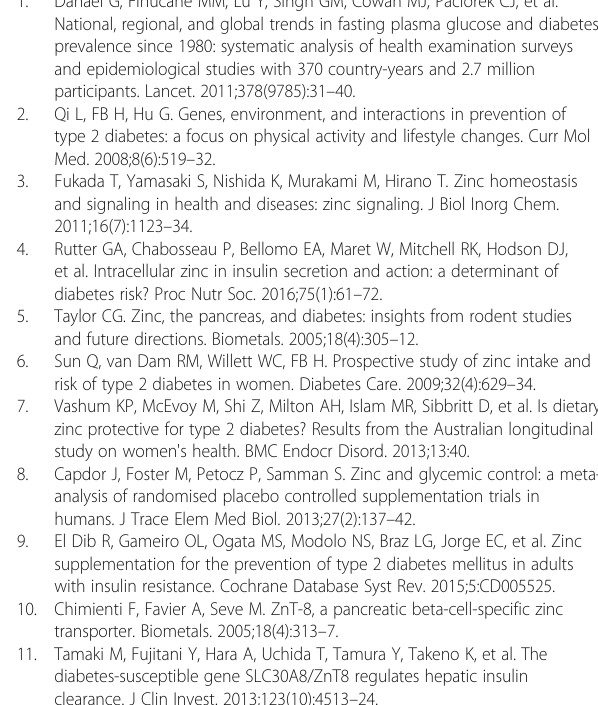
Additional file 1: Figure S1. Flow chart of analytical study population. Figure S2. Nelson-Aalen cumulative hazard estimates for type 2 diabetes by SLC30A8 rs13266634 genotype among 20,929 participants in the Malmö Diet and Cancer Study ( P logrank = 0.0005). Table S1. Baseline characteristics by type 2 diabetes (T2D) status in the Malmö Diet and Cancer Study at baseline (1991 – 1996). Table S2. Baseline characteristics by SLC30A8 genotype (rs13266634) in the Malmö Diet and Cancer Study at baseline (1991 – 1996). (DOCX 10736